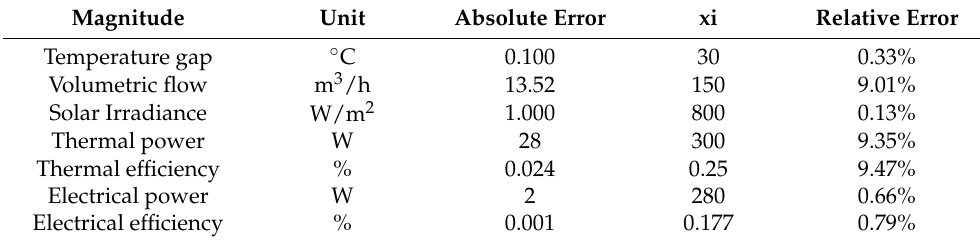
Table 3. Values of absolute and relative error for main magnitudes in testing rig. Magnitude Unit Absolute Error xi Relative Error Temperature gap ◦ C 0.100 30 0.33% Volumetric flow m 3 /h 13.52 150 9.01% Solar Irradiance W/m 2 1.000 800 0.13% Thermal power W 28 300 9.35% Thermal efficiency % 0.024 0.25 9.47% Electrical power W 2 280 0.66% Electrical efficiency % 0.001 0.177